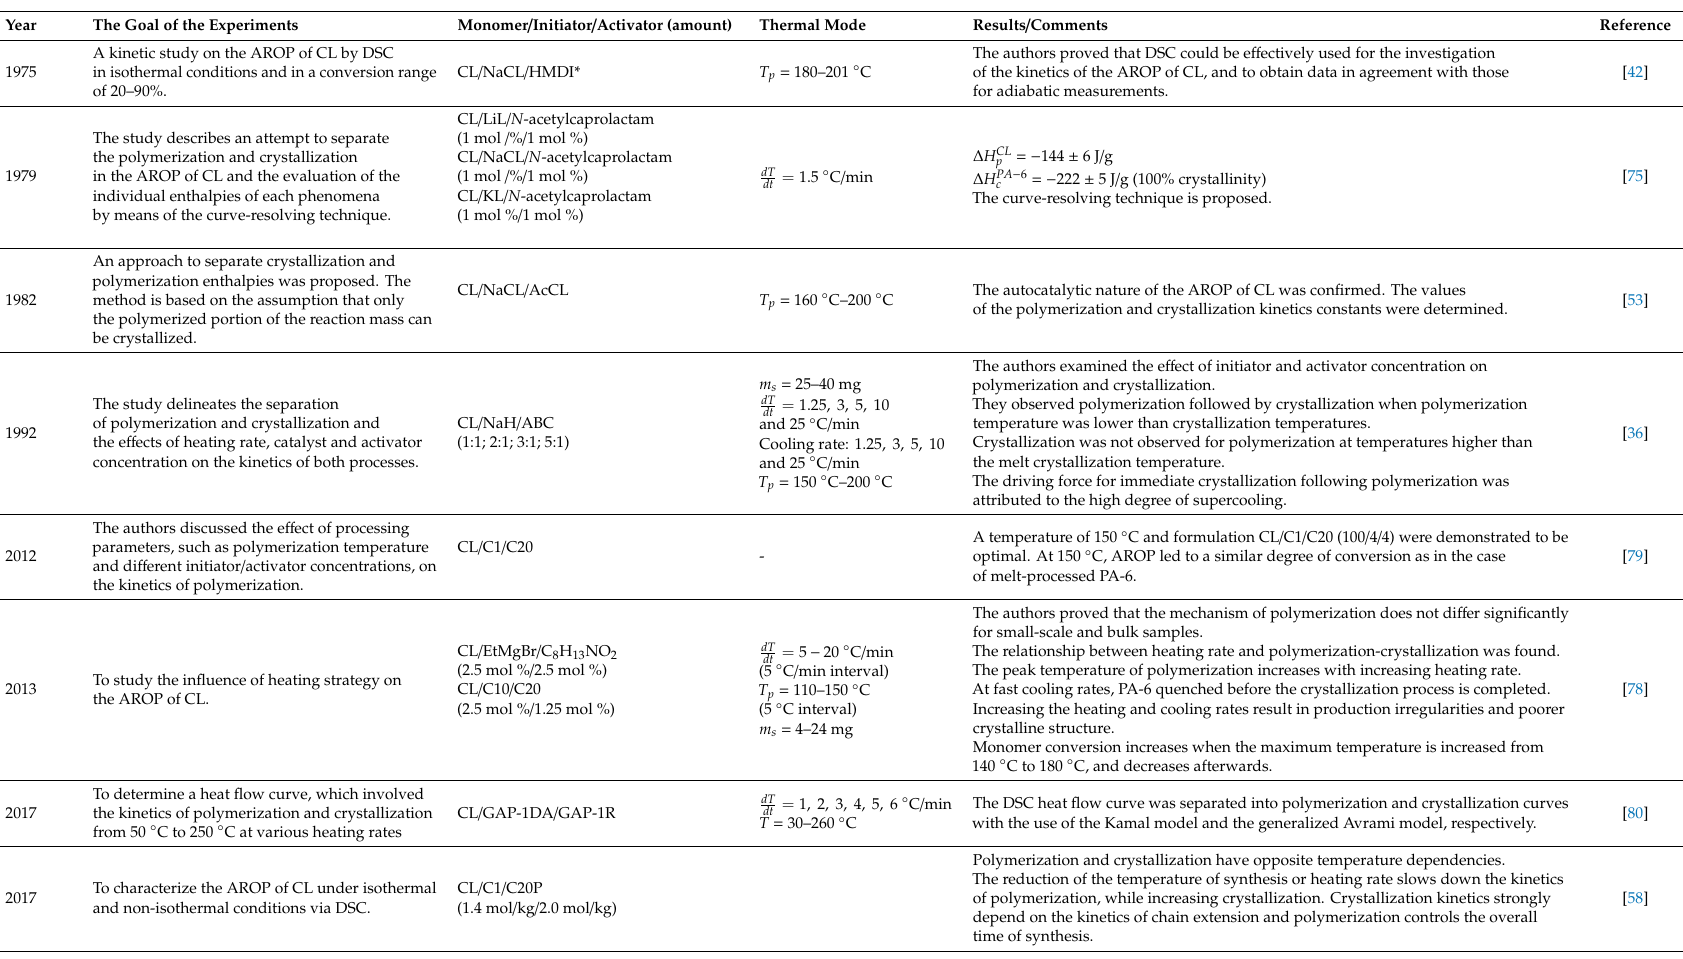
Table 1. DSC test